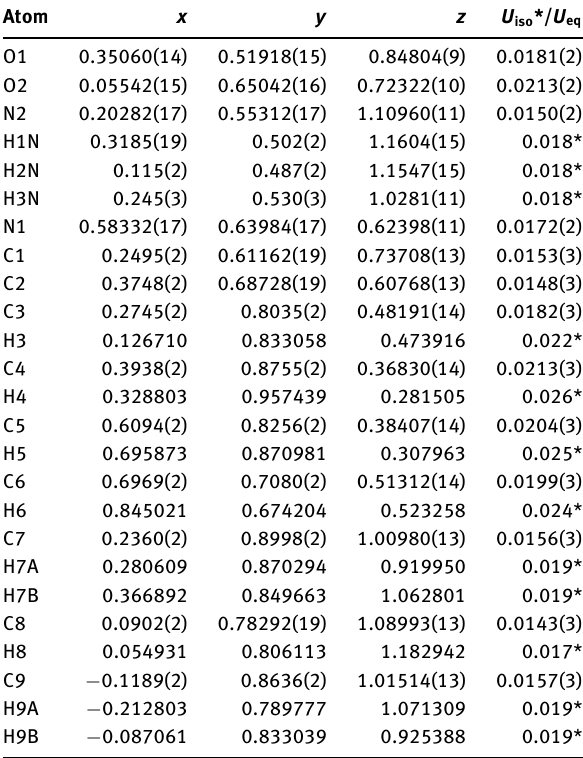
Table 2: Fractional atomic coordinates and isotropic or equivalent isotropic displacement parameters (Å 2